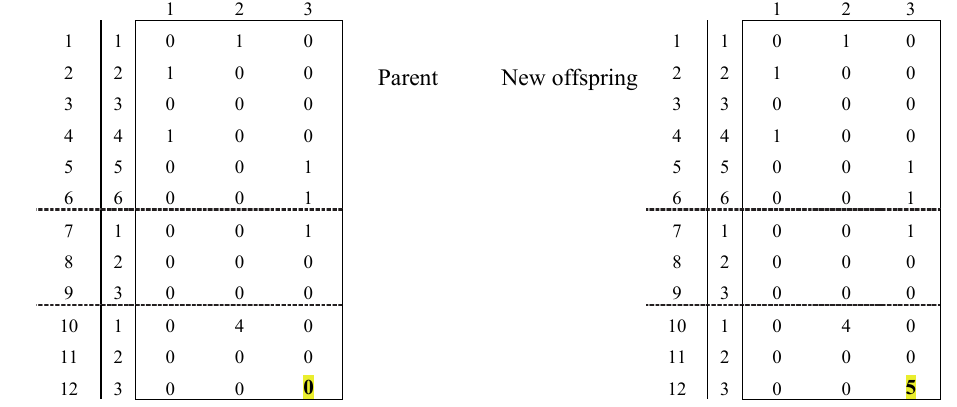
Fig. 5. An example of the mutation operator in the discrete